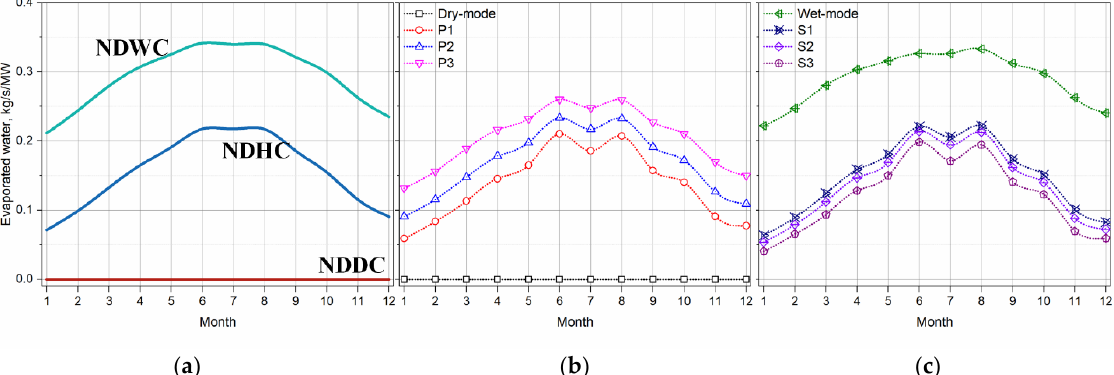
Figure 10. Water evaporated loss of the unit heat transfer rate in (kg/s)/MW. ( a ) NDDC, NDWC and NDHC, ( b ) parallel mode of NDHC, ( c ) serial mode of NDHC.